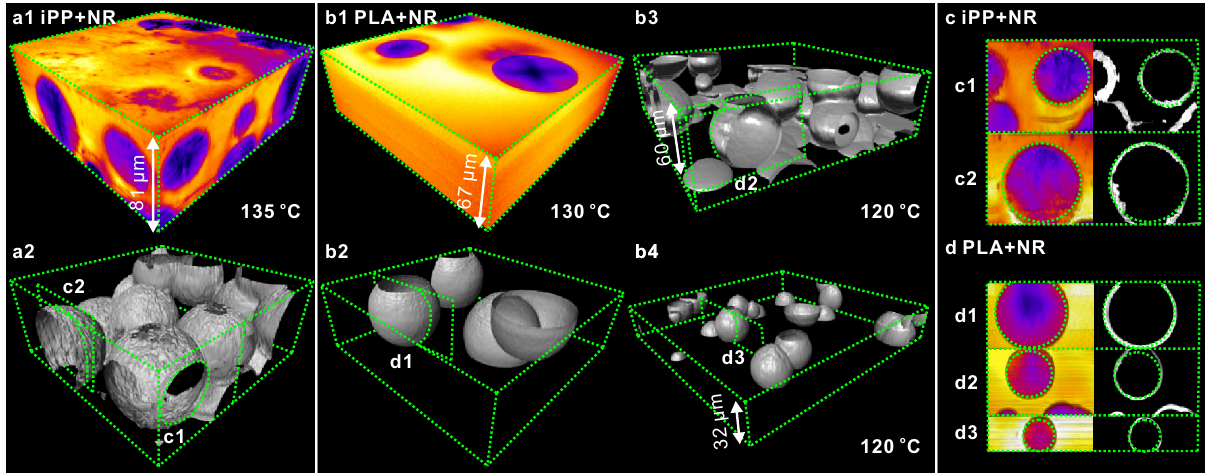
Fig. 2 3D images of growing spherulites in NR-labeled polymers. a iPP isothermally crystallized at T c = 135 °C for 12 min, then quenched in ice water, showing spherulites whose growth had been arrested: ( a1 ) false-color solid representation (color scale as in Fig.1); ( a2 ) same region, showing surfaces of a maximum gradient in fl uorescence intensity, thus marking the envelope of arrested spherulites. b The same for PLA: ( b1 , b2 ) false-color solid and maximum gradient (surface) rendering, respectively, of the same region, T c = 130 °C; ( b3 , b4 ) two PLA samples crystallized at T c = 120 °C. c , d Vertical sections through selected spherulites of ( c ) iPP in panel a , and d PLA in panel b ; left: false color, right: maximum gradient rendering. Sections shown in c , d are indicated in the corresponding panels a , b , respectively. Note some vertical elongation of certain spherulites, especially near sample surface, made clear by comparison with the inscribed green reference circles. Note also the difference between the “ wrinkly ” surface of iPP and the smooth surface of PLA